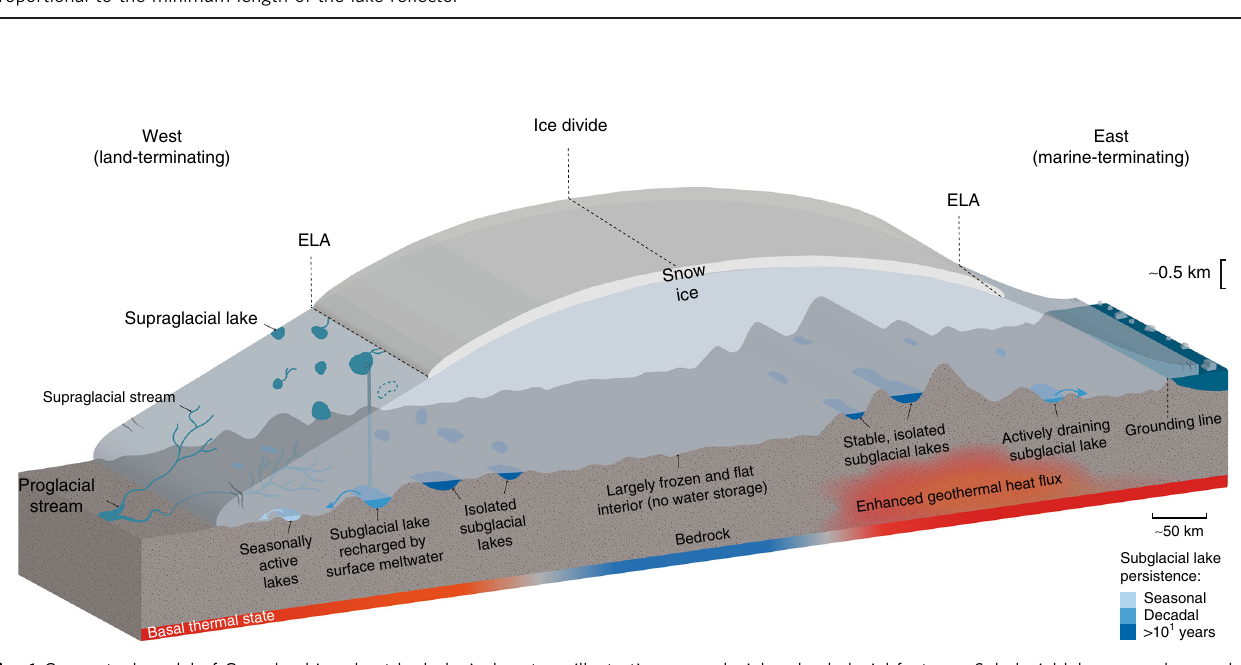
Fig. 5 Comparison between location of identi fi ed subglacial lakes and predicted lakes, geothermal heat fl ux, basal thermal state and bed roughness. a Predicted subglacial lake locations, using Shreve hydraulic potential equation and varying fl otation fractions ( f ) overlain on the BedMachine DEM error map 28 . Lakes in black coincide with hydraulic minima (using f = 0.9), whilst those in red were not successfully predicted. b Estimated geothermal heat fl ux derived from magnetic data 29 . c Predicted basal thermal state 1 (blue = likely frozen, white = uncertain, red = likely thawed). d Dimensionless bed roughness beneath the GrIS 33 , measured using the fast Fourier transform approach which converts bed topography (derived from radar echo sounding) into the frequency domain. Known subglacial lakes in existing literature are shown by black circles (RES-detected) and squares (detected through elevation changes). Deep ice core locations are depicted by black triangles. Lakes identi fi ed in this study are shown by circles, and the size of the circle is proportional to the minimum length of the lake re fl ector